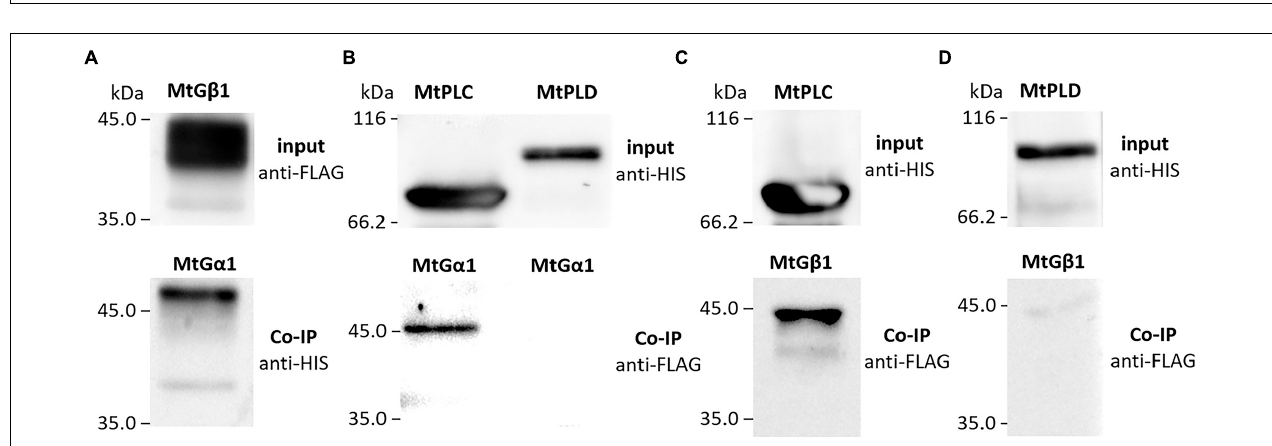
FIGURE 3 | Localization of MtGbeta1 expression in M. truncatula non-inoculated and inoculated roots, nodule primordia and 2-week-old nodules carrying a pMtGbeta1:GUS genetic construct. (A) Non-inoculated roots. (B) Inoculated roots. (C) Nodule primordia (50 µ m section). (D) Young nodule (50 µ m section). (E) A general view of the nodule. Image was done using dark field like illumination (E–G) Two-week-old nodules (50 µ m section). I, meristem zone; II, infection zone; III, nitrogen fixation zone; arrows indicate vascular bundles (Vb). Scale bars are 50 µ m (B,C) and 100 µ m (A,D–G) .